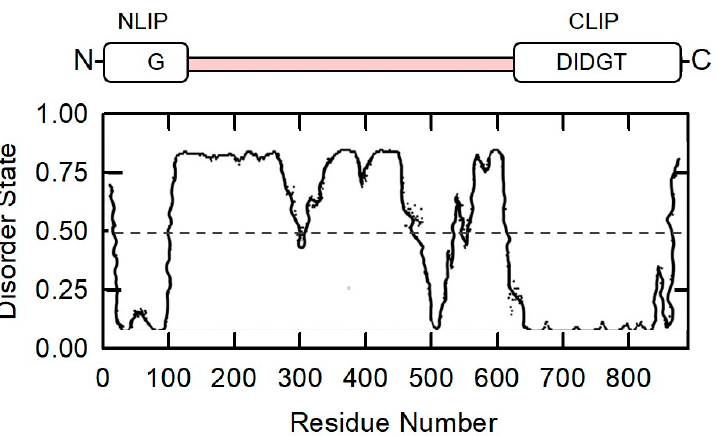
Figure 4. The domain structure and prediction of intrinsically disordered regions in Lipin 1- α are presented. NLIP and CLIP domains are in the N- and C-termini of Lipin 1- α , respectively. DIDGT is the catalytic motif in CLIP domain. Protein sequence was analyzed using the DISOPRED3 algorithm (http://bioinf.cs.ucl.ac.uk/psipred/) (accessed on 15 May 2021).